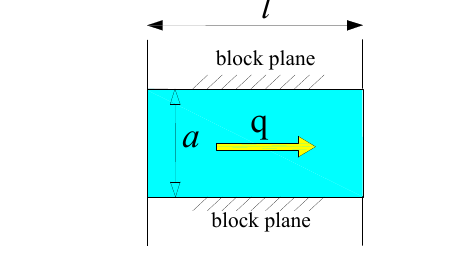
Figure 3. The fluid flow rate of contact.